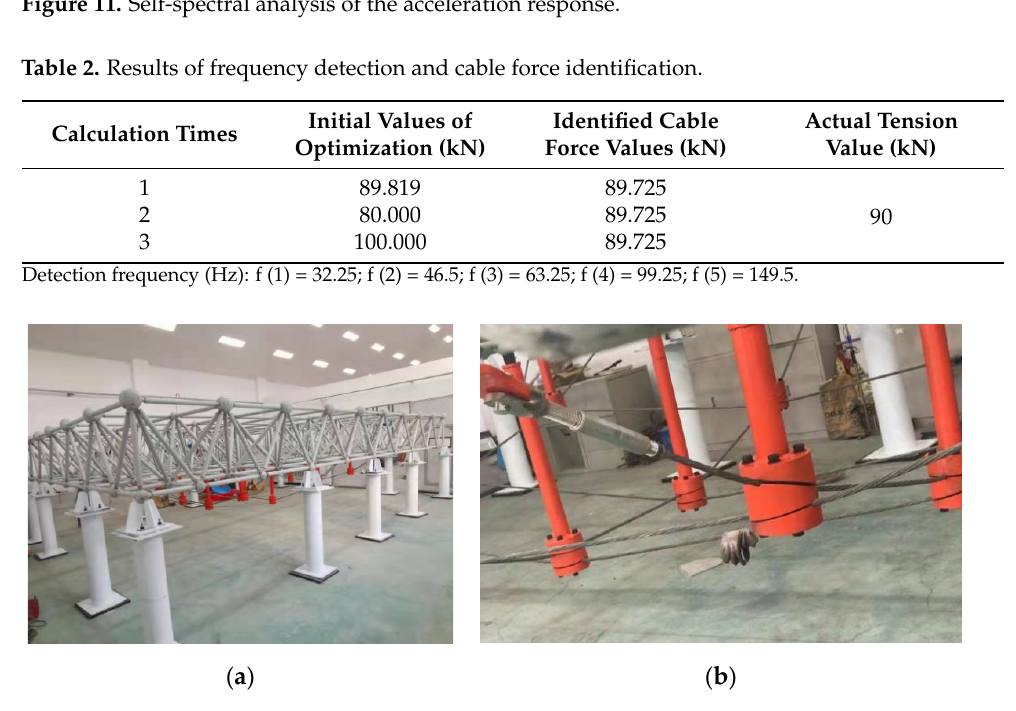
Figure 12. ( a ) Large-span space structure cable force identification test platform. ( b ) Cable